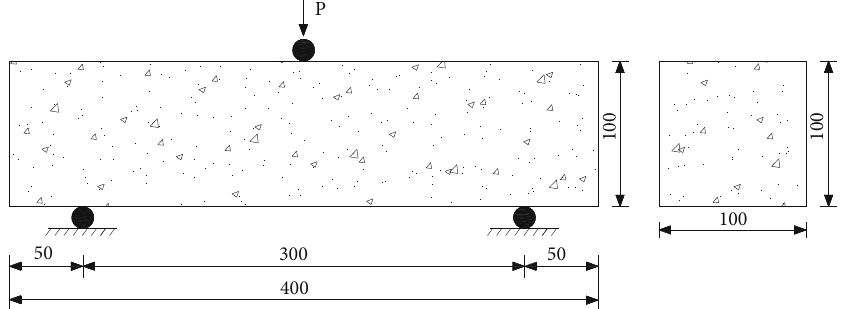
Figure 22: The schematic diagram of fl exural test.